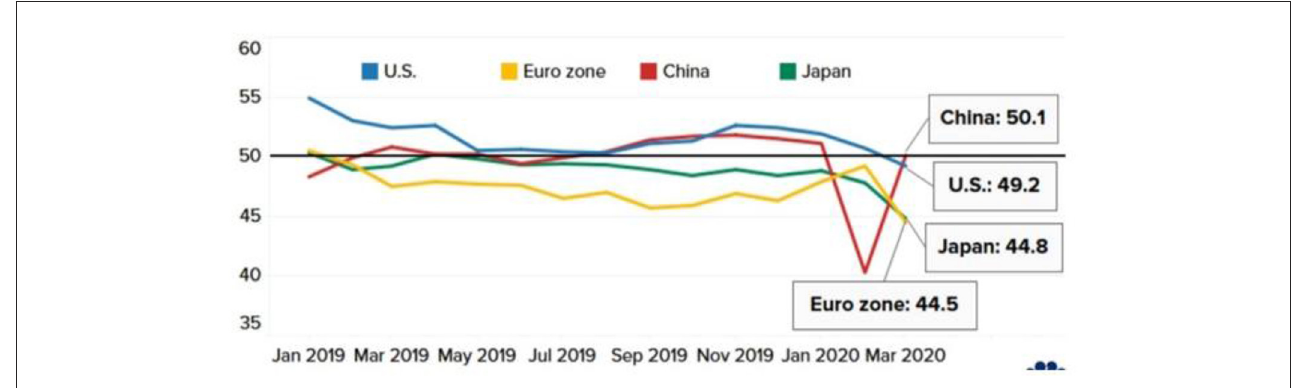
FIGURE9 Manufacturing in significant economies. Source: IHS Market, Caixin, au Jibun Bank,